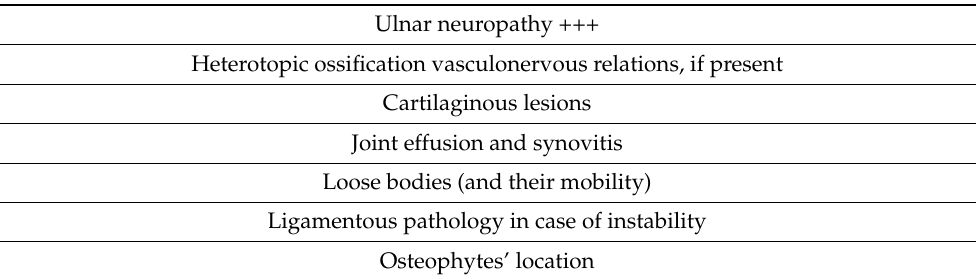
Table 3. Ultrasonographic